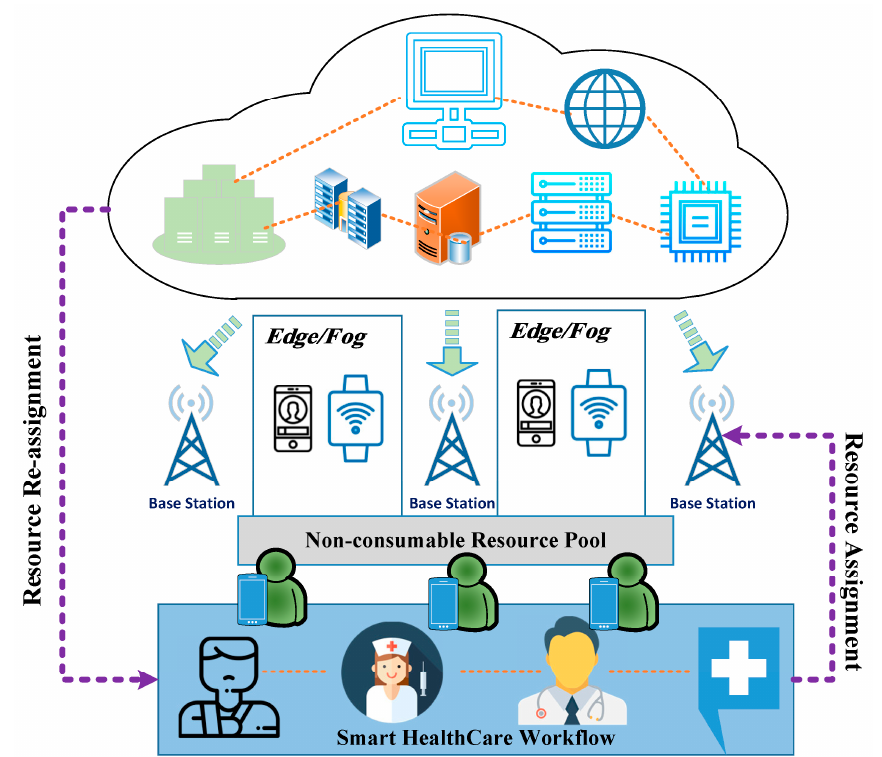
Figure 2. Edge-based medical healthcare system.